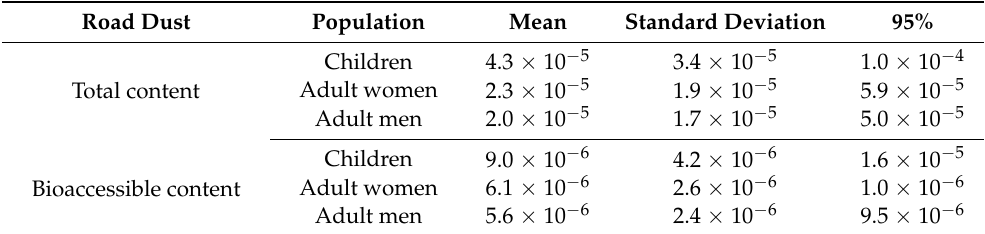
Table 3. Carcinogenic risks of trace metals in road dust using total and bioaccessible content. The acceptable threshold is 1.0 × 10 − 6